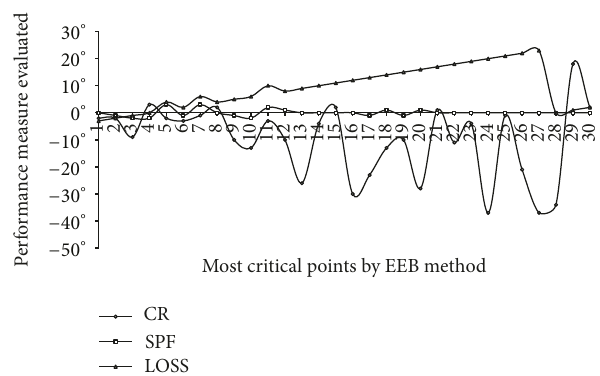
Figure 3: Difference between EEB and CR and LOSS and SPF ranks.